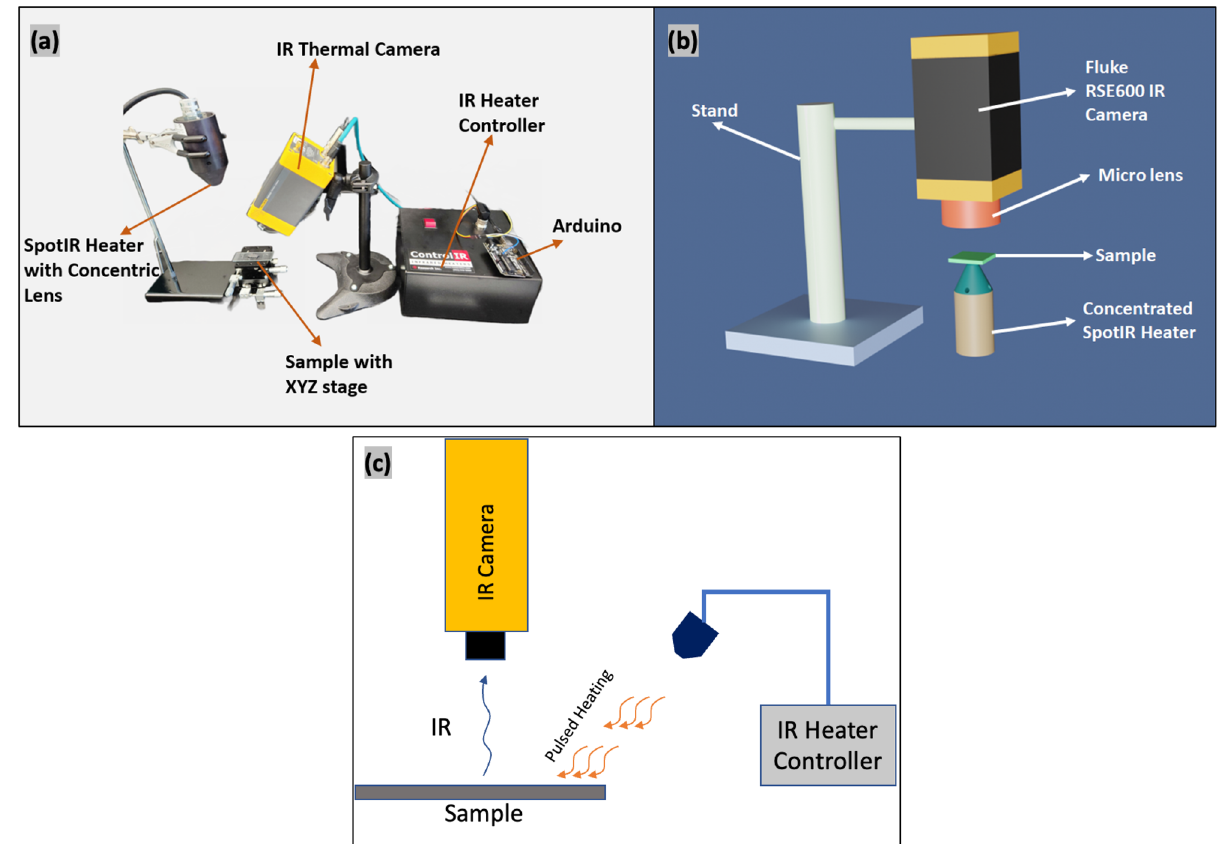
Figure 1. ( a ) Setup for dispersion and thermal characteristics analysis for polymer composites via infrared thermography, ( b ) schematic of thermal diffusivity testing for polymer composites, ( c ) schematic of IR heating on a sample surface and IR capturing via Fluke RSE600 thermal